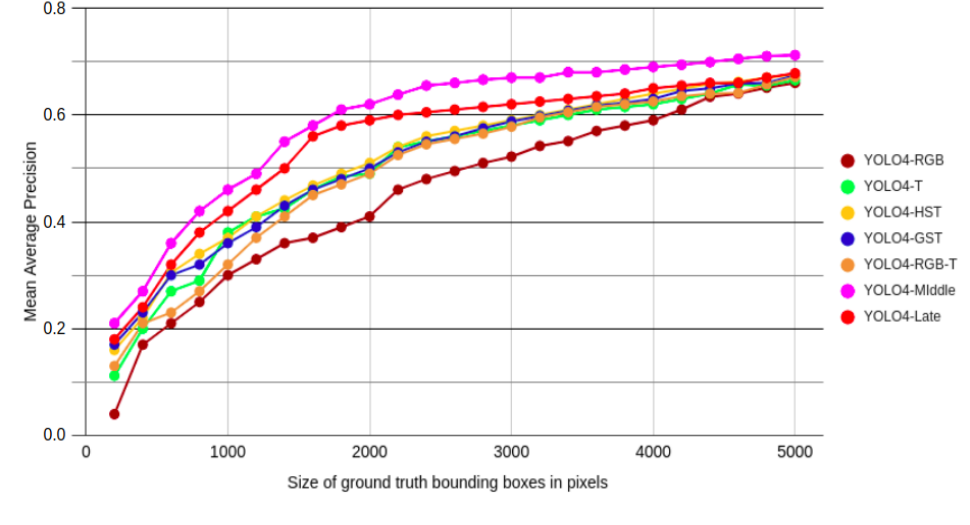
Figure 8. The plot of the mAP 50 metric for different sizes of ground truth bounding boxes in a range from 200 to 5000 pixels and different configurations of the proposed detector.